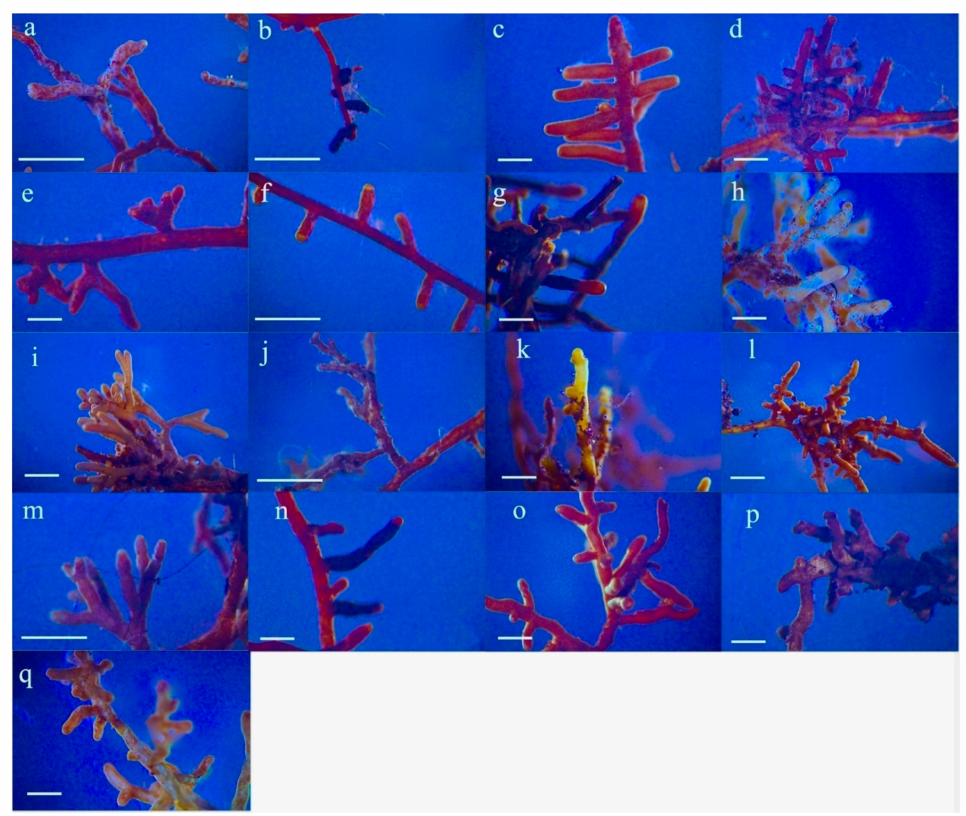
Figure 2. Ectomycorrhizas observed on Q. robur ( Quercus robur L.) trees in the Bialowie˙za old-growth forest: ( a ) Amanita citrina Pers., ( b ) Cenococcum geophilum Fr., ( c ) Clavulina sp., ( d ) Humaria hemisphaerica (F.H. Wigg.), ( e ) Inocybe lanuginose (Bull.) P. Kumm., ( f ) Laccaria sp., ( g ) Hyaloscypha bicolor (Hambl. & Sigler) Vohn í k, Fehrer & R é blov á , ( h ) Pachyphlodes nemoralis Hobart, B ó na & Conde, ( i ) Russula amoenolens Romagn., ( j ) Russula nigricans (Bull.) Fr., ( k ) Russula ochroleuca (Pers.) Fr., ( l ) Scleroderma citrinum Pers., ( m ) Thelephora terrestris Ehrh., ( n ) Tomentella sp., ( o ) Tylospora asterophora (Bonord.) Donk., ( p ) Xerocomellus porosporus (Imler ex G. Moreno & Bon) Šutara, ( q ) Xerocomellus sp. Bars in each photograph indicate 1 mm